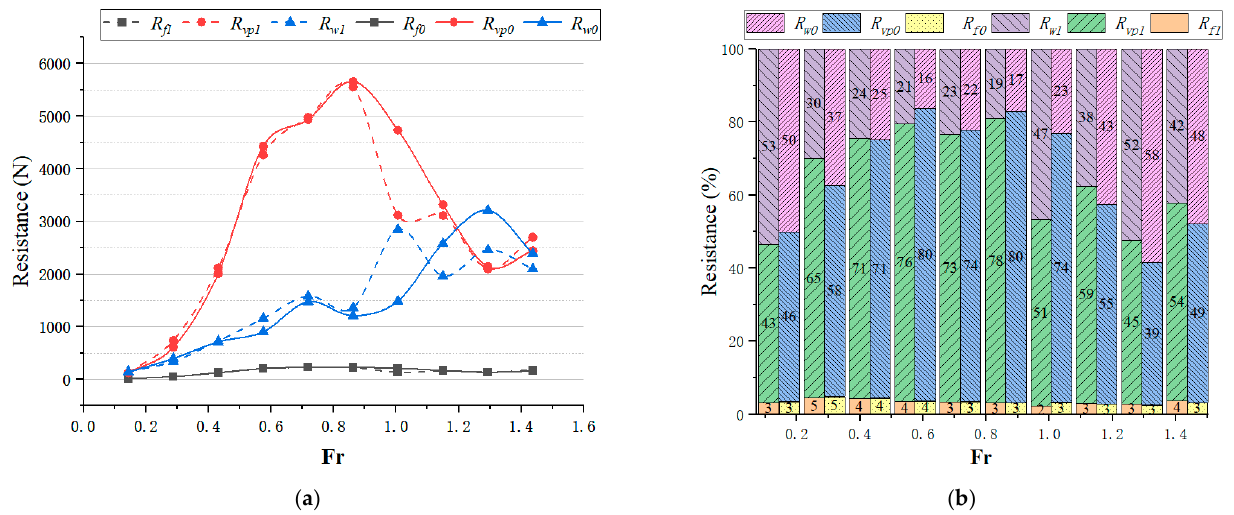
Figure 16. Resistance with and without Flanks at different Froude numbers (solid line and subscript 0—Origin; dotted line and subscript 1—Flanks). ( a ) Resistance composition, ( b ) proportion of composition.